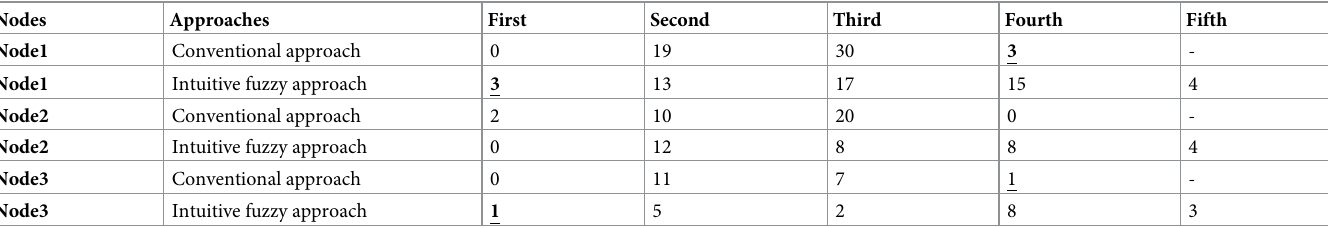
Table 5. Frequency distribution of risks in conventional and intuitive fuzzy HAZOP approaches in three nodes. Nodes